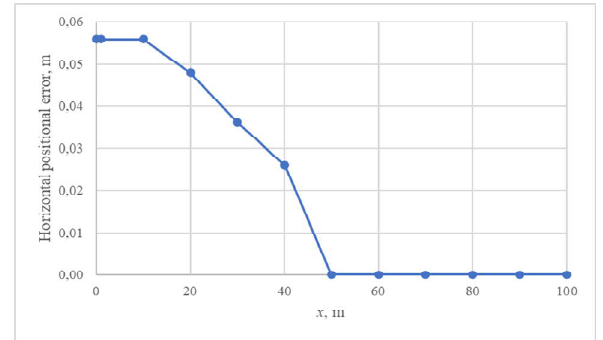
Figure 9 . Road sign after adjustment: ( а ) top view; (b) left Figure 10 . An example of the dependence between a horizontal view; (c) front view. positional error on a road sign and x value when there is vegetation among many pole-like